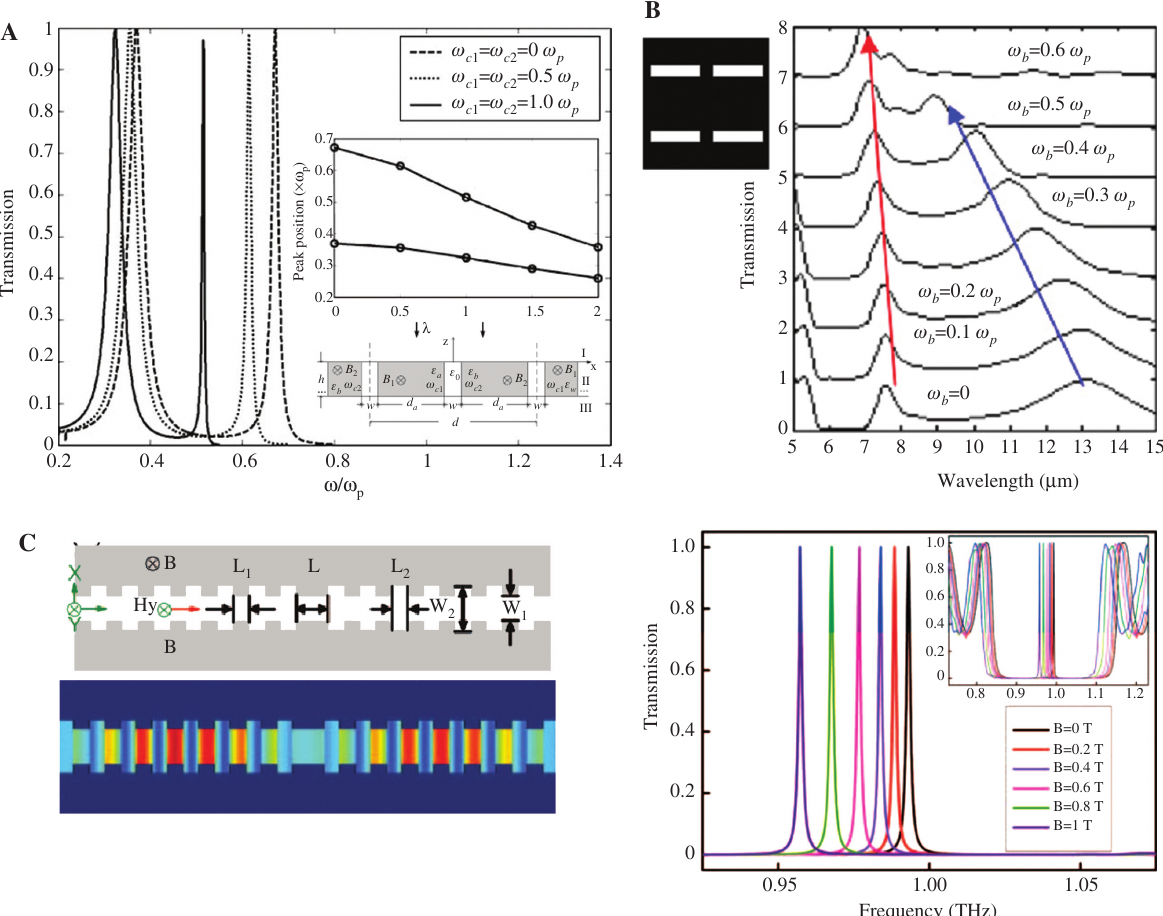
Figure 6: SMPs filters based on 1D grating (A) (from [69]), 2D grating (B) (Reprinted from Solid State Commun, 149, Zhou R, Li H, Zhou B, Wu L, Liu X, Gao Y, Transmission through a perforated metal film by applying an external magnetic field, 657–661, Copyright (2009), with permission from Elsevier), and Bragg grating (C) (Li K, Ma X, Zhang Z, Wang L, Hu H, Xu Y, Song G., Highly tunable Terahertz filter with magneto-optical Bragg grating formed in semiconductor-insulator-semiconductor waveguides, AIP Advances, Vol. 3, (2013); used in accord- ance with the Creative Commons Attribution 3.0 Unported License). All these filters can be tuned by the external magnetic